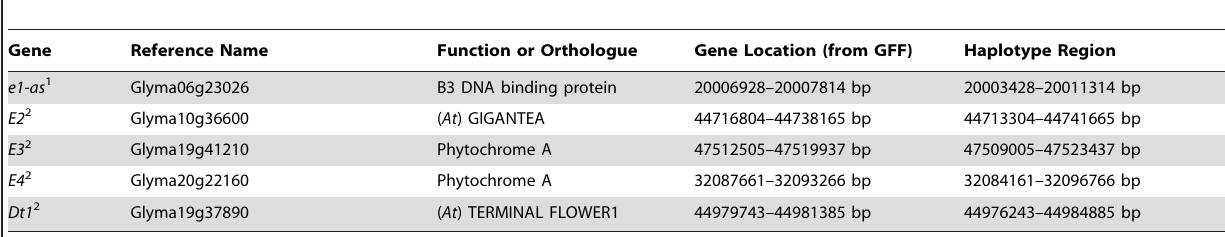
Table 1. Major flowering time/maturity genes present in the Williams 82 reference sequence and positions used around those genes for haplotype